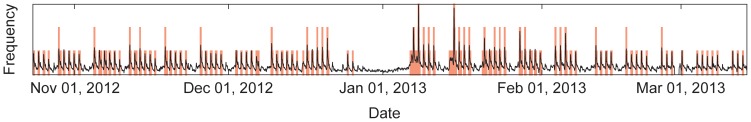
Breaks of the periodicities for the keyword school originating in the circadian rhythm causing the following bursts to be larger.